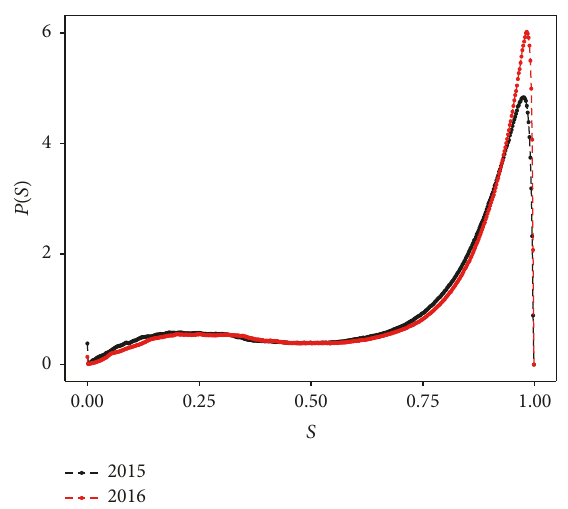
Figure 5: Estimated probability density of similarity values 𝑃(𝑆) for the fully connected, weighted, similarity matrix S